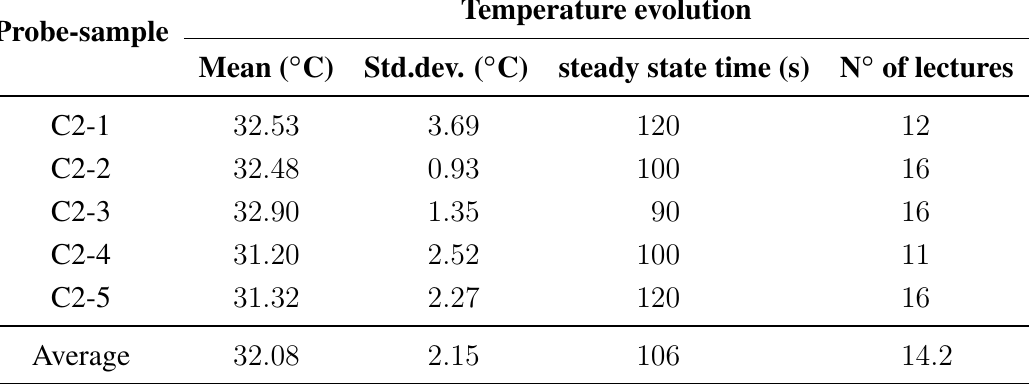
Table 4. Temperature dynamics in C2 and C3 probes at on-line testbed